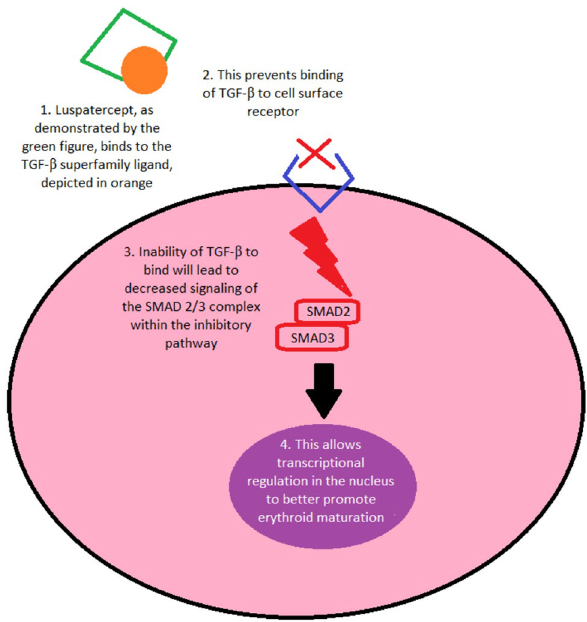
Fig. 1 Schematic of the mechanism of action of